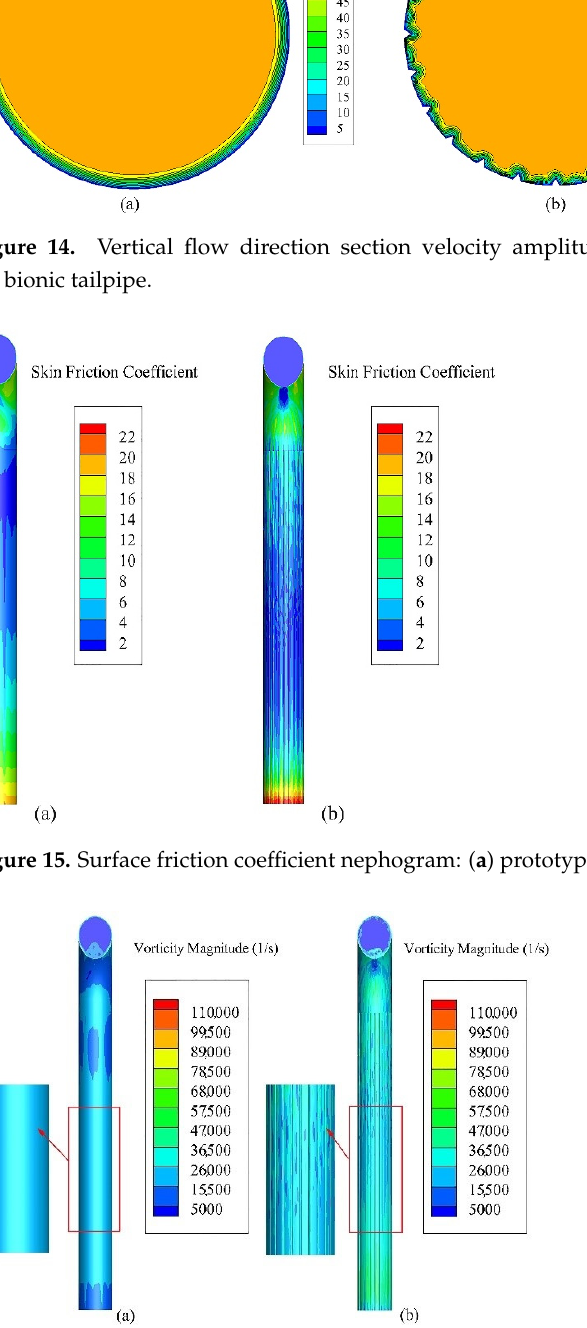
Figure 16. Vorticity amplitude nephogram ( a ) prototype and ( b ) bionic tailpipe.